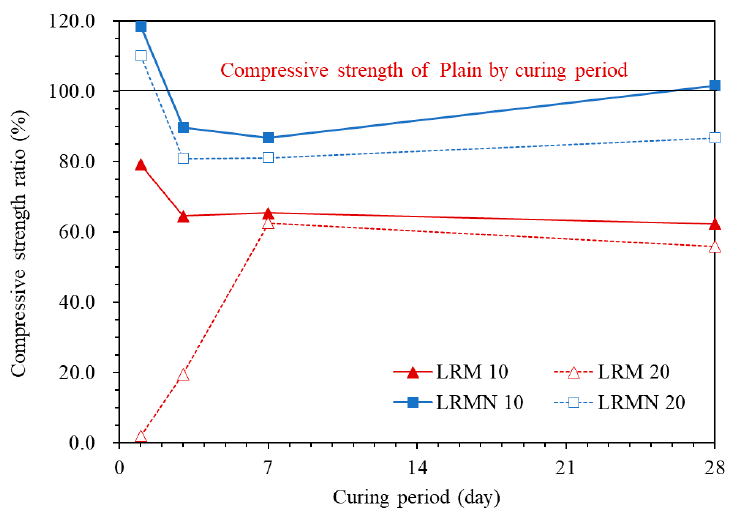
Figure 5. Compressive strengths of the cement pastes normalized to that of Plain as a function of the curing period.